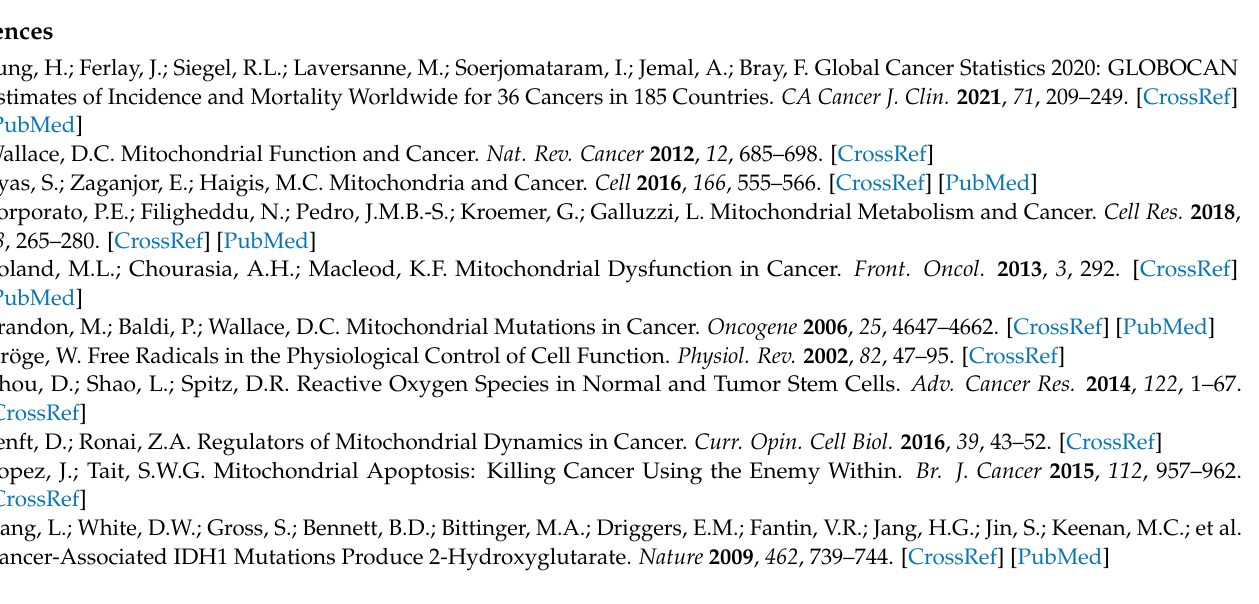
Table S7. Statistical analysis of cell numbers of CA, CGA, Arc treatments, alone and in combination, in MCF-10A cells; Table S8. Statistical analysis of cell numbers of CA, CGA, Arc treatments, alone and in combination, in MCF-12F